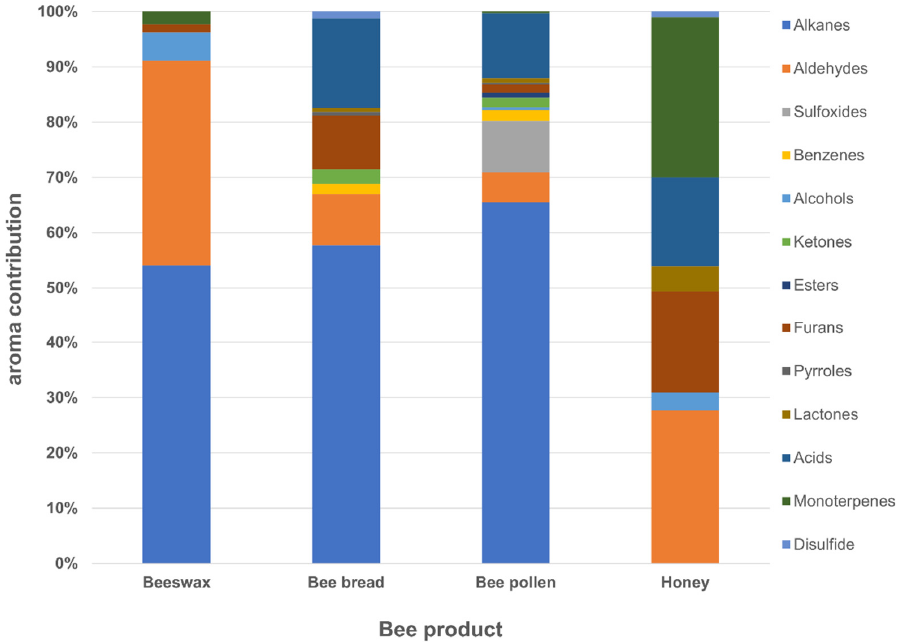
Figure 1. Chemical classes contribution of volatile compounds detected in bee products.